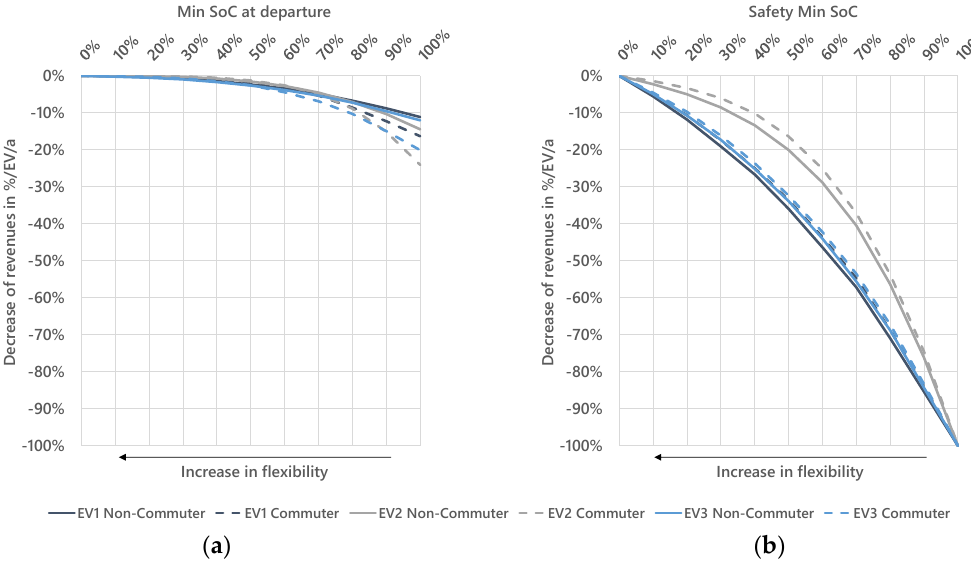
Figure 7. ( a ) Influence of a minimum SoC at departure on revenue potentials of bidirectionally chargeable EVs using arbitrage trading; ( b) influence of a minimum SoC at the place of residence on revenue potentials of bidirectionally chargeable EVs using arbitrage trading.